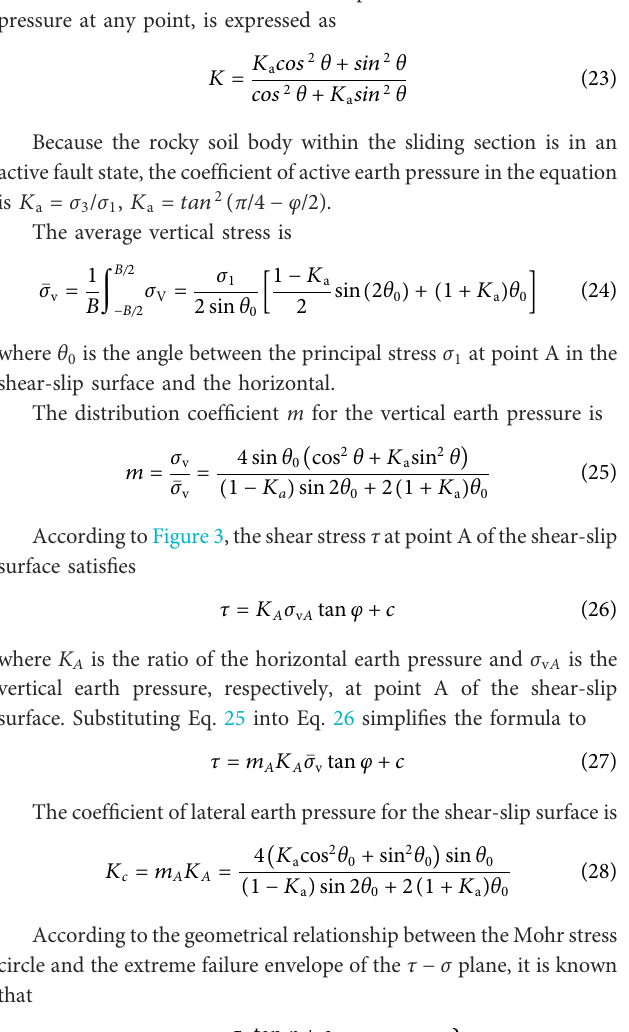
FIGURE 4 Comparative analysis of lateral earth pressure coef fi